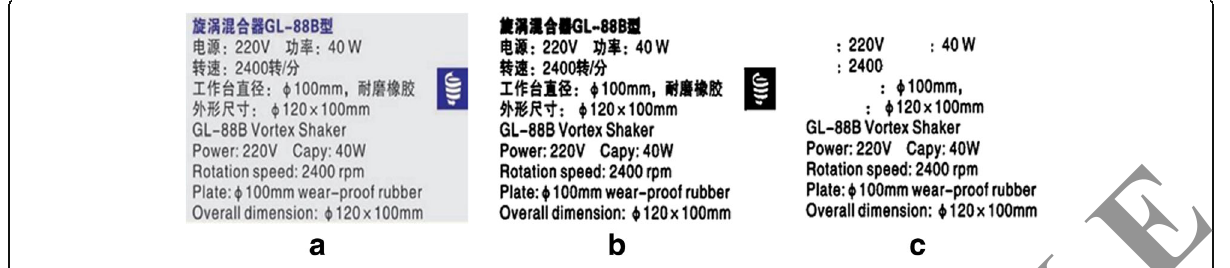
Fig. 6 English recognition of mixed images in English and Chinese